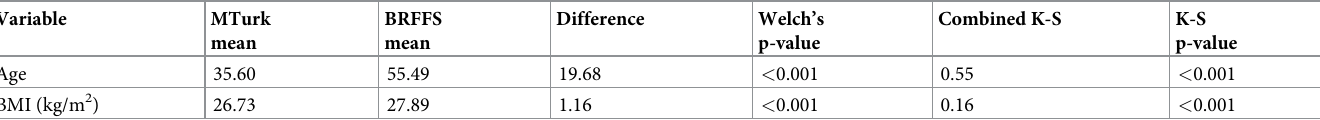
Table 2. Summary and comparison of continuous variables between MTurk and national samples.